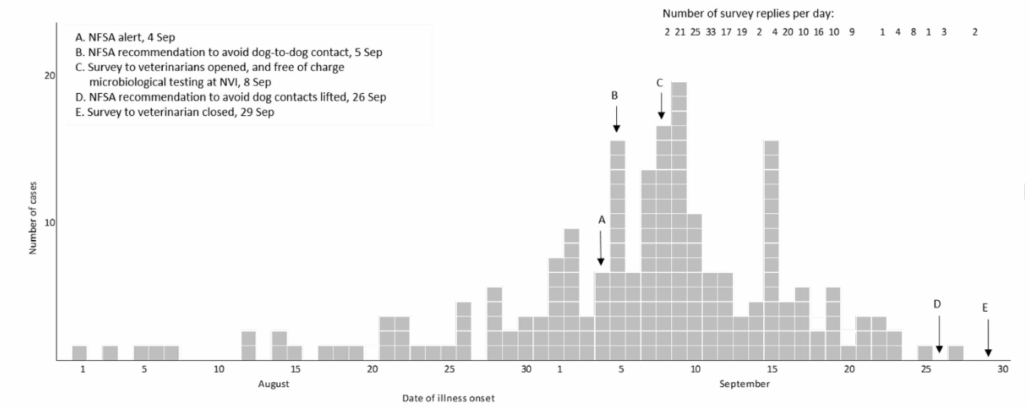
Figure 1. Day of illness onset for cases ( n = 207) of acute haemorrhagic diarrhoea in dogs, and number of replies per day, in online survey to veterinarians, Norway 2019.